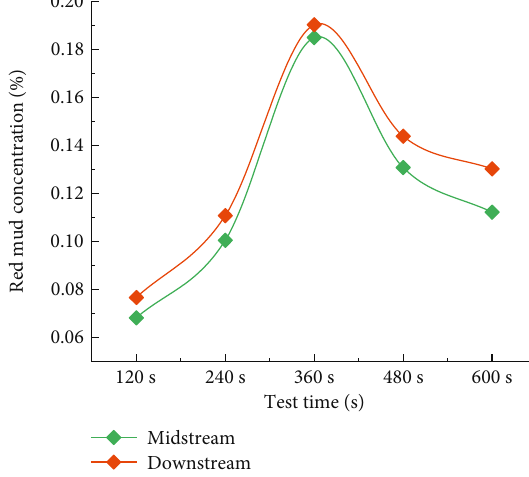
Figure 6: Red mud concentrations at the dam midstream and downstream (middle of slope and dam